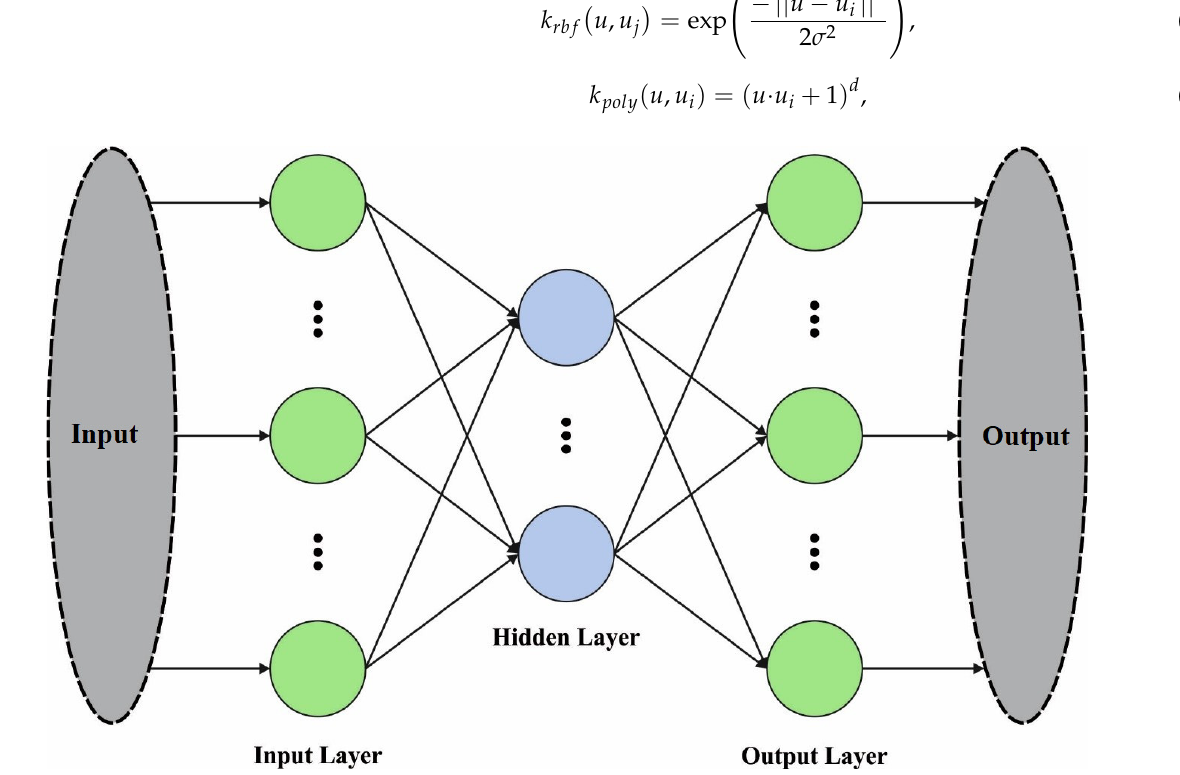
Figure 2. Structure of ELM model.